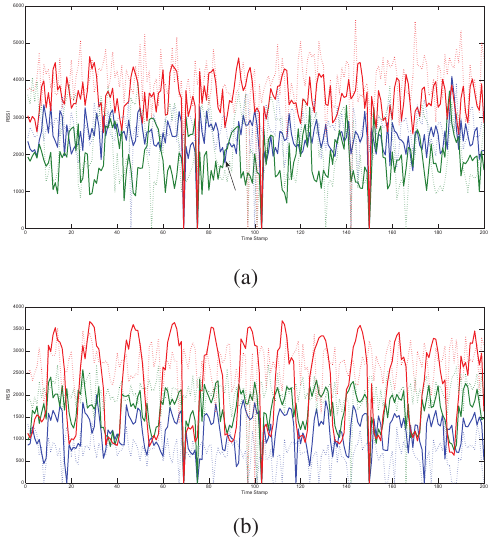
Figure 5: Illustration of RSSI fluctuations of falling right and falling left: RSSIs of tag 1, tag 2 and tag 3 (top) and RSSIs of tag 7, tag 8 and tag